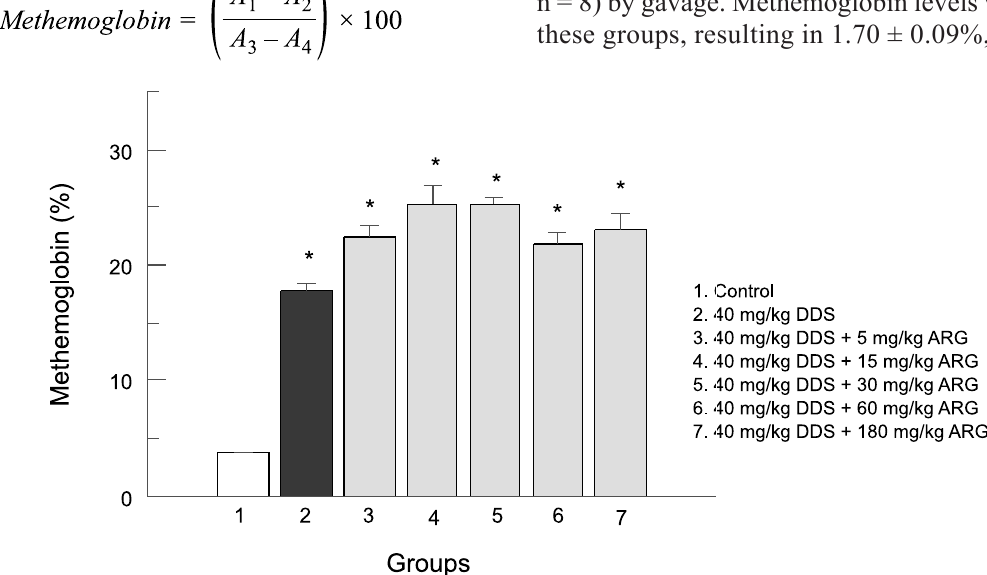
FIGURE 1 - Effect of single dose ARG on methemoglobin levels (%). Animals were treated with ARG at 5, 15, 30, 60 and 180 mg/kg doses (p.o., gavage) 2 hours prior to the administration of 40 mg/kg of DDS (i.p.). Data expressed as means ± standard deviation. *p < 0.05 compared to control